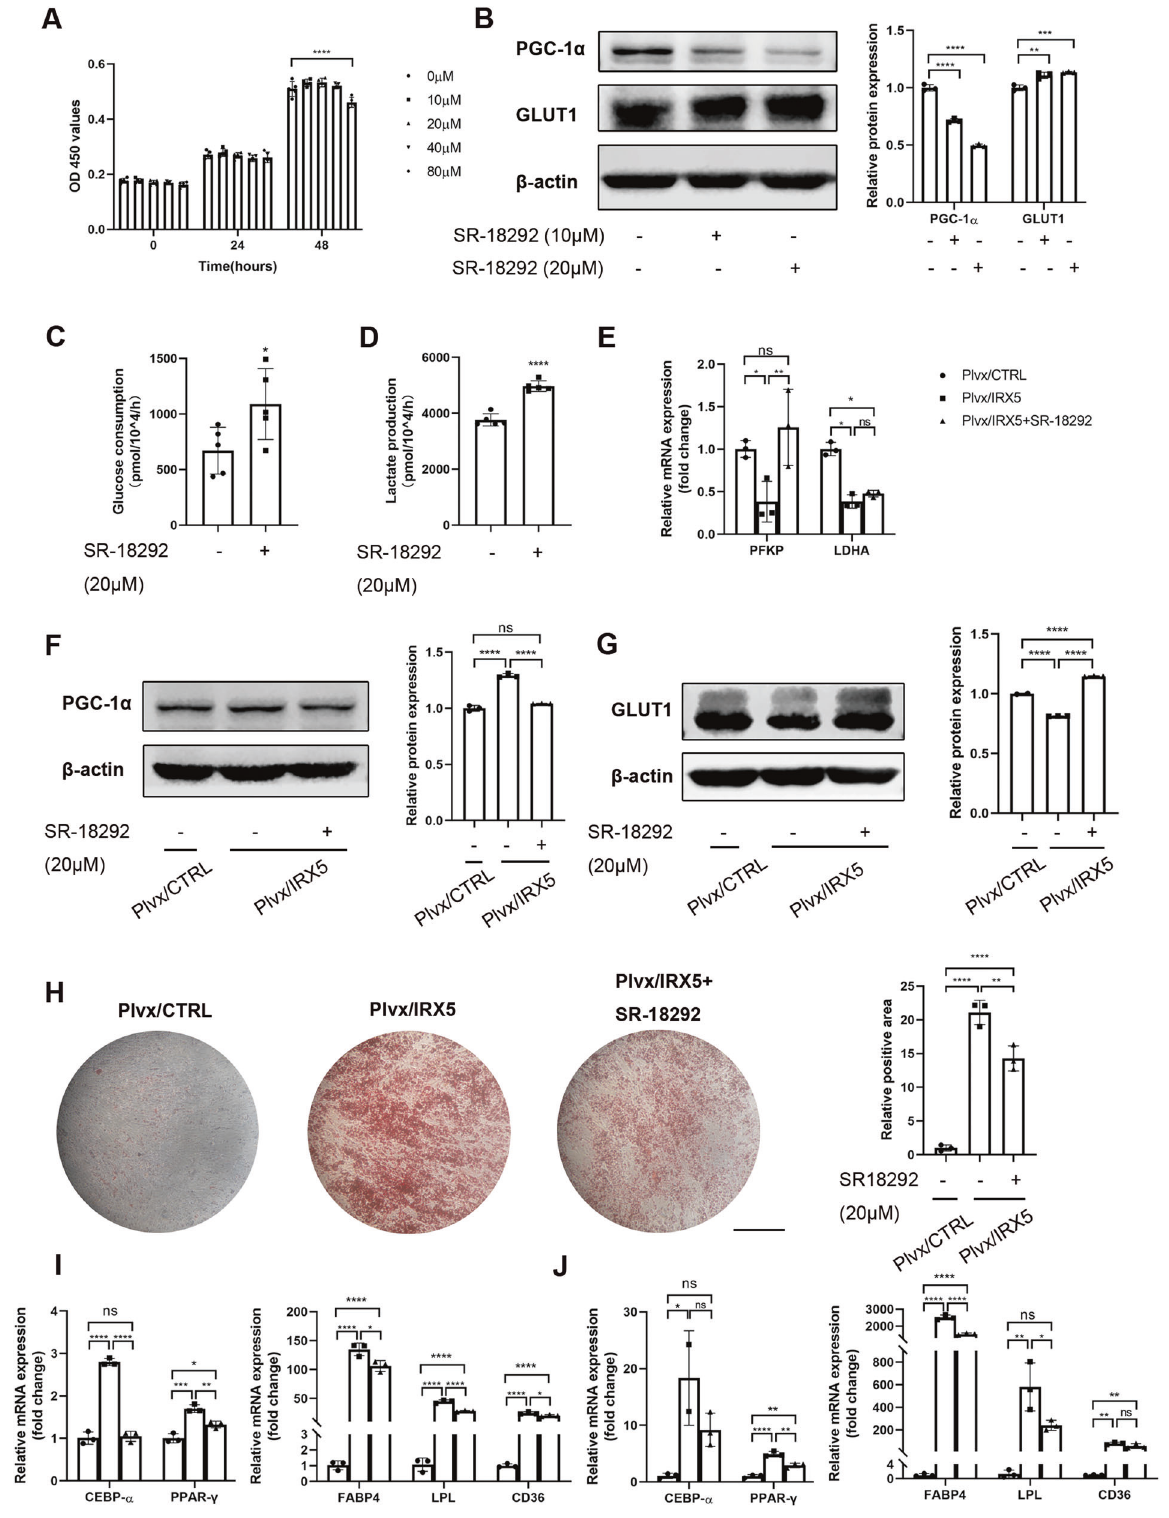
uptake and lactate production in hMSCs (Fig. 6C, D). Meanwhile, reduced mRNA expression of glycolysis-related genes, PFKP and LDHA , and GLUT1 protein expression in Plvx/IRX5 group were reversed by SR-18292 (Fig. 6E – G and Fig. S6B – C). Accumulation of lipid droplets of the Plvx/IRX5 group after 16 days of adipogenic